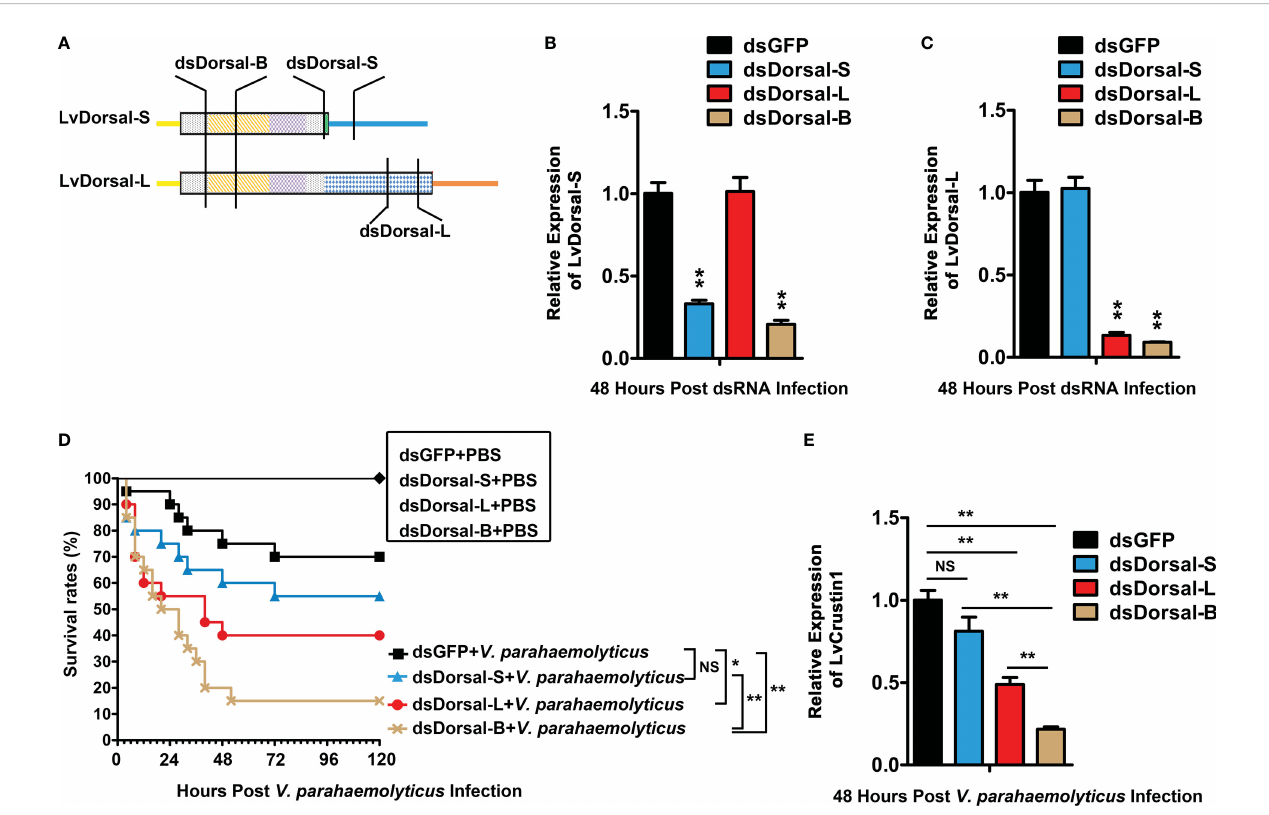
FIGURE 5 Function of LvDorsals during V. parahemolyticus infection. (A) Illustration of dsRNA-LvDorsal-S, dsRNA-LvDorsal-L, and dsRNA-LvDorsal-B target sequences. (B) QPCR analysis of the silencing ef fi ciency of LvDorsal-S. (C) QPCR analysis of LvDorsal-L silencing ef fi ciency. (D) Survival rates of LvDorsal- silenced shrimp during V. parahemolyticus infection. (E) QPCR analysis of LvCrustin1 expression levels after V. parahemolyticus infection in dsRNA- LvDorsal-S, dsRNA-LvDorsal-L, and dsRNA-LvDorsal-B groups. The hemocyte from 3 shrimp were sampled for QPCR. **p < 0.01; *p < 0.05; ns, no signi fi